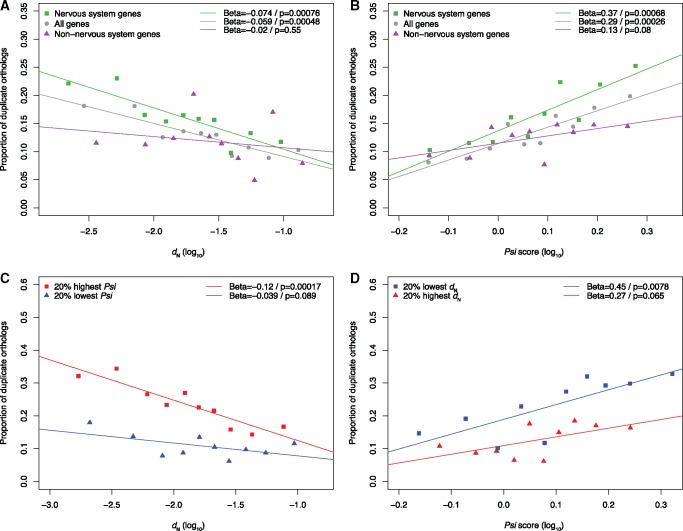
(A) Relation between proportion of mouse orthologs of zebrafish 3R ohnologs and rate of nonsynonymous substitution. Genes were split into ten equal-sized bins of dN, and the median dN of each bin was plotted on the x-axis (in log10 scale). A linear regression was fit to the ten data points, whose slope (Beta value) and P-value are indicated in the top-right corner of the plot. The analysis including all genes is plotted in grey and circles, whereas the analysis including only nervous system genes is plotted in green and squares and the analysis including only nonnervous system genes is plotted in purple and triangles. (B) Relation between proportion of mouse orthologs of zebrafish 3R ohnologs and Akashi’s test Psi score, for nervous and nonnervous system genes. Legend similar to (A). (C) Similar to (A), using only nervous system genes, divided in two groups: the 20% genes with lowest Psi score plotted in blue and squares, and the 20% genes with highest Psi score plotted in red and triangles. (D) Similar to (B), using only nervous system genes, divided in two groups: the 20% genes with lowest dN plotted in blue and squares, and the 20% genes with highest dN plotted in red and triangles.